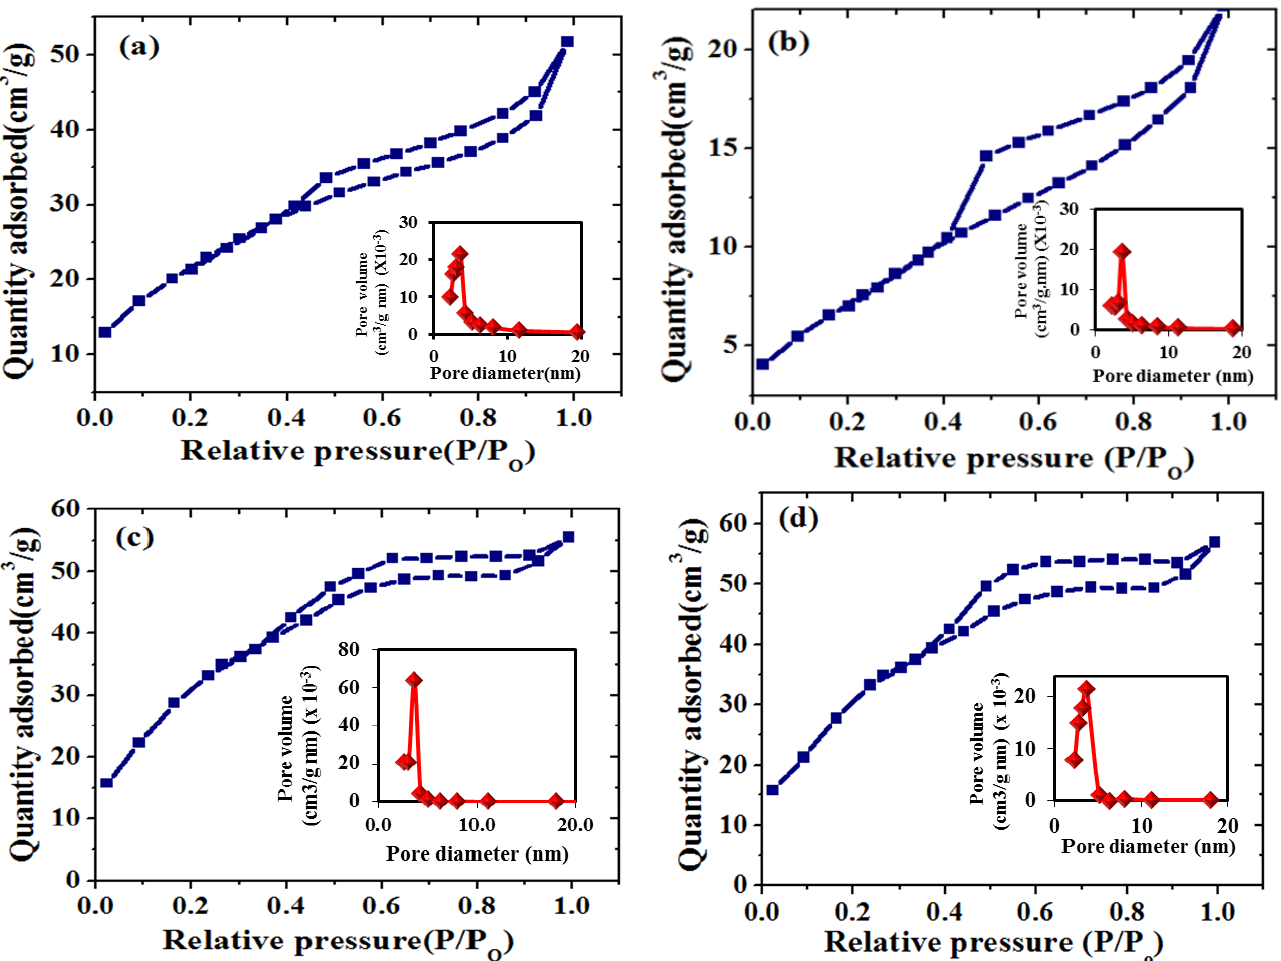
Figure 5. BET isotherm curves of ( a ) SrFe 2 O 4 , ( b ) TiFe 2 O 5 , ( c ) Sr 0.7 Ti 0.3 Fe 2 O 4.3 and ( d ) Sr 0.4 Ti 0.6 Fe 2 O 4.6 .